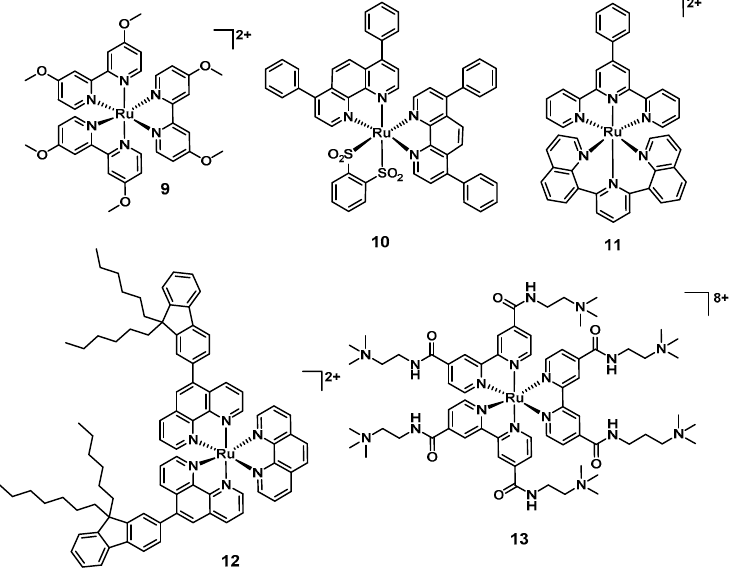
Figure 5. Structures of aPDT-active ruthenium polypyridyl complexes.